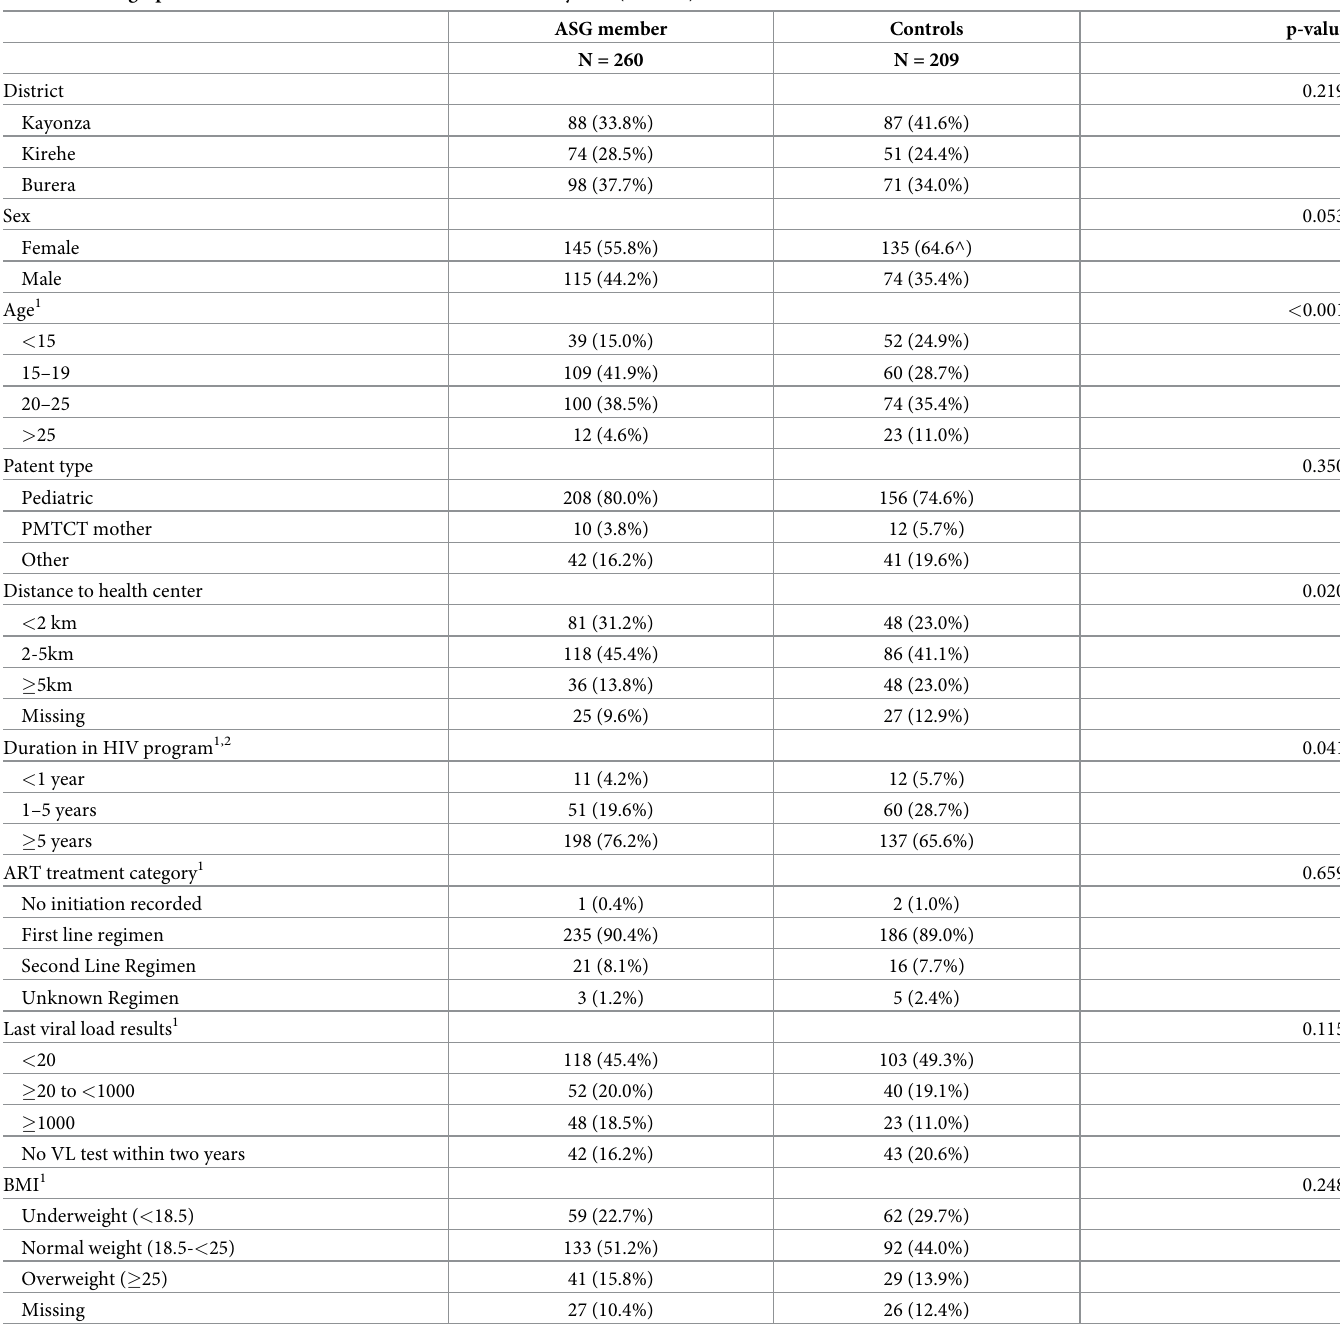
Fig 1. Flowchart of study participants. 1 ASG members were excluded if they did not attend their assigned site during the enrollment period. Non-members were excluded if they did not attend any participating sites during the enrollment period. https://doi.org/10.1371/journal.pgph.0000492.g001 Table 2. Demographic characteristics of ASG members and control youth (N =